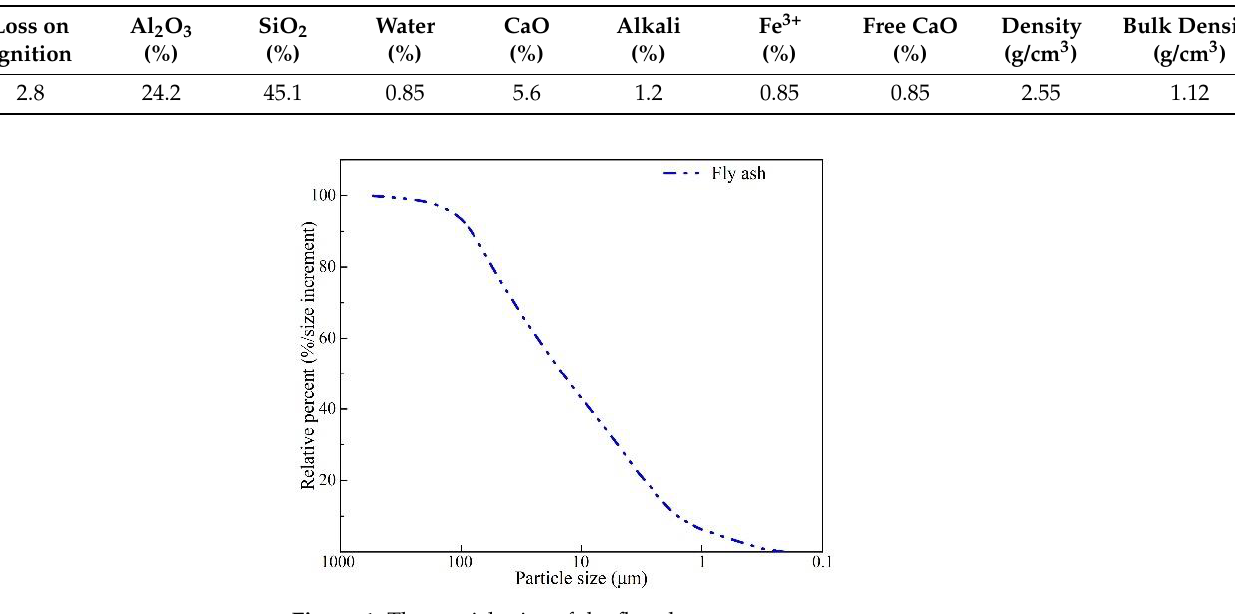
Figure 1. The particle size of the fly ash.